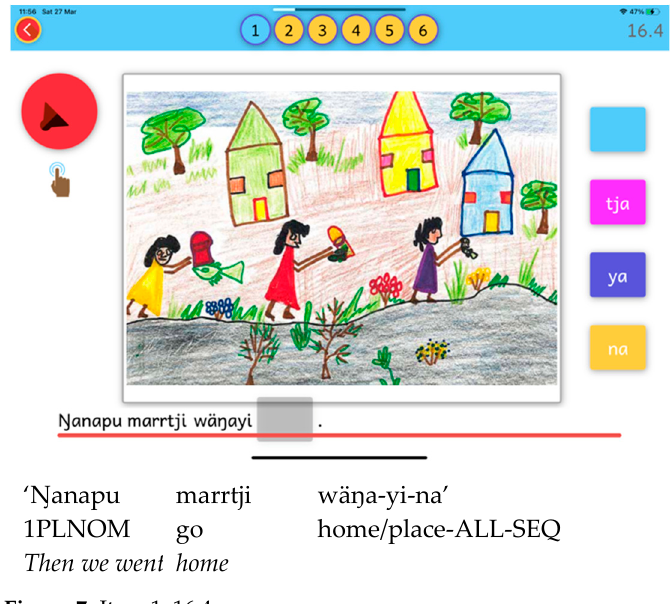
Figure 7. Item 1,